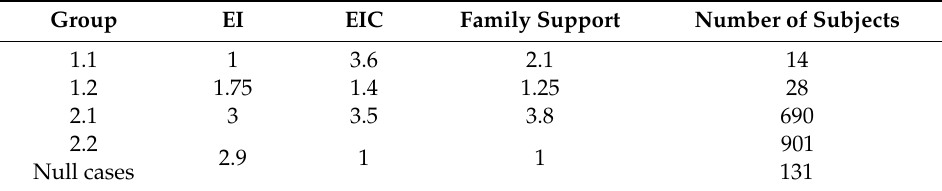
Table 2. Average scores of entrepreneurial interest (EI) and family's interest in the young becoming entrepreneurial (EIC) and number of subjects per group.